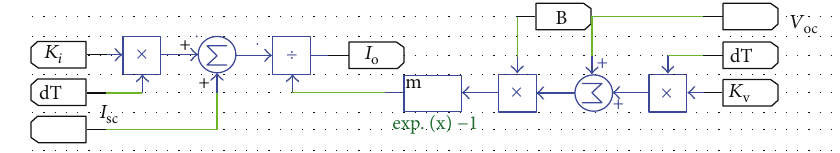
Figure 7: Model of